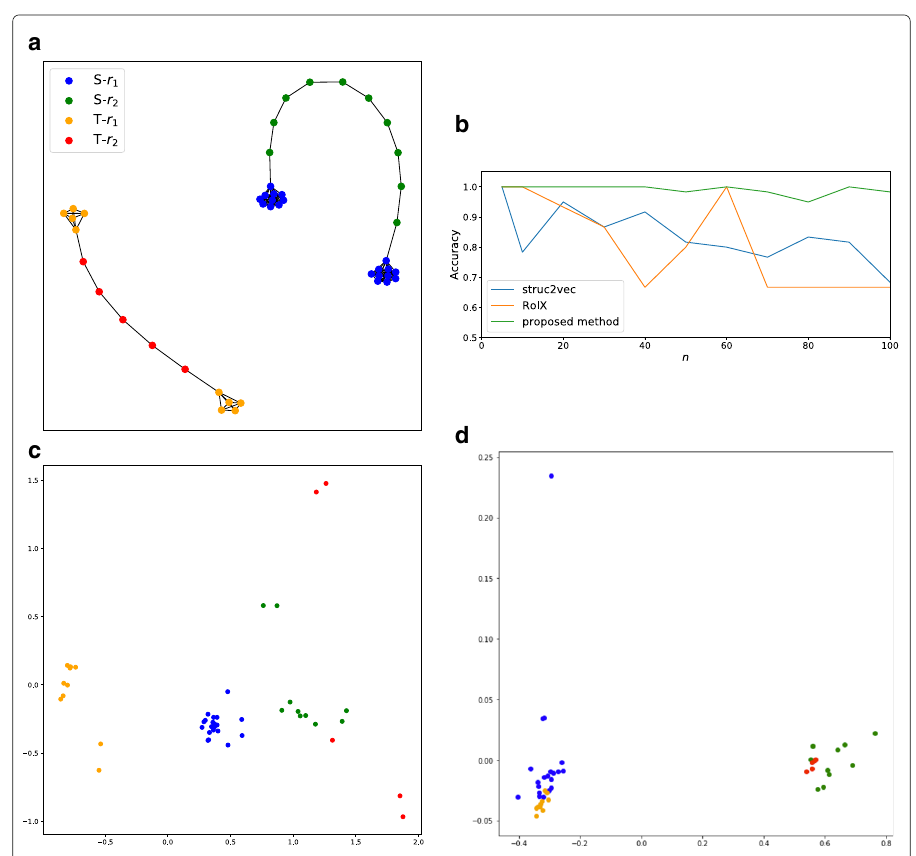
Fig. 3 Barbell graphs. a B a ( 5,5 ) (lower left) and B b ( 10,10 ) (upper right), where color indicates different roles in the same domain and S and T represent the source and the target networks, respectively. b Transition of the accuracy when we changed the source network size n . Nodes are mapped by ( c ) struc2vec and ( d ) proposed method. Visualization was performed by